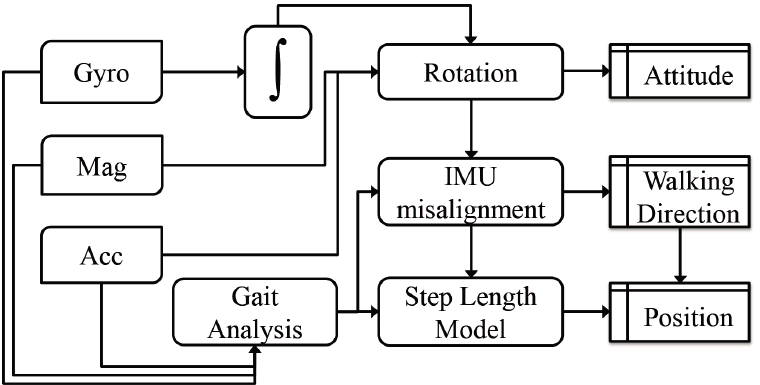
Figure 2. Pedestrian Dead Reckoning (PDR) mechanization equations with handheld tri-axis inertial sensors and tri-axis